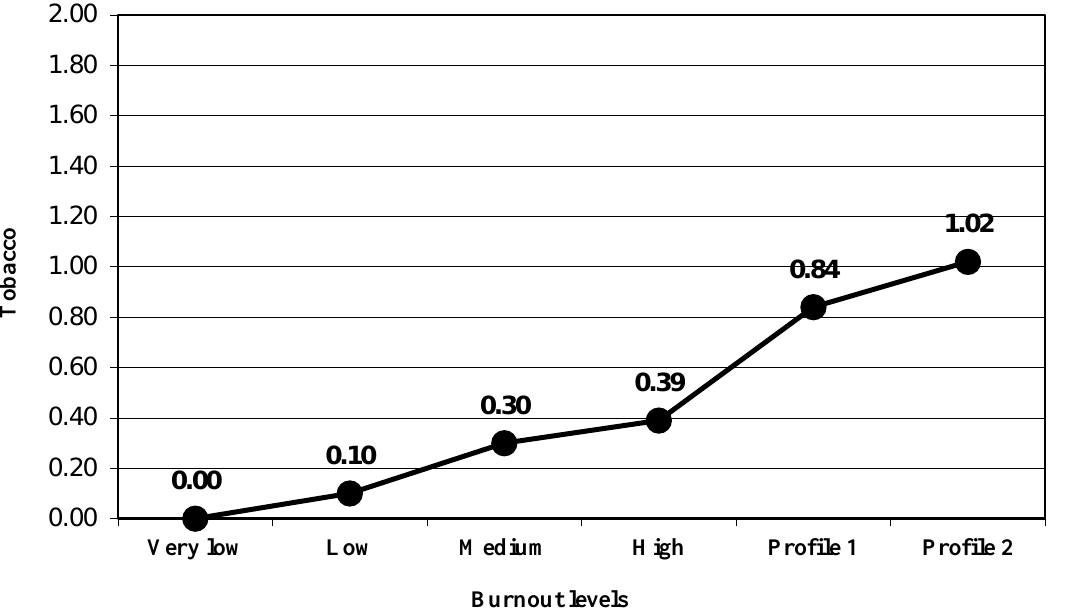
Figure 3. Mean in the alcohol intake variable for the groups of burnout levels.